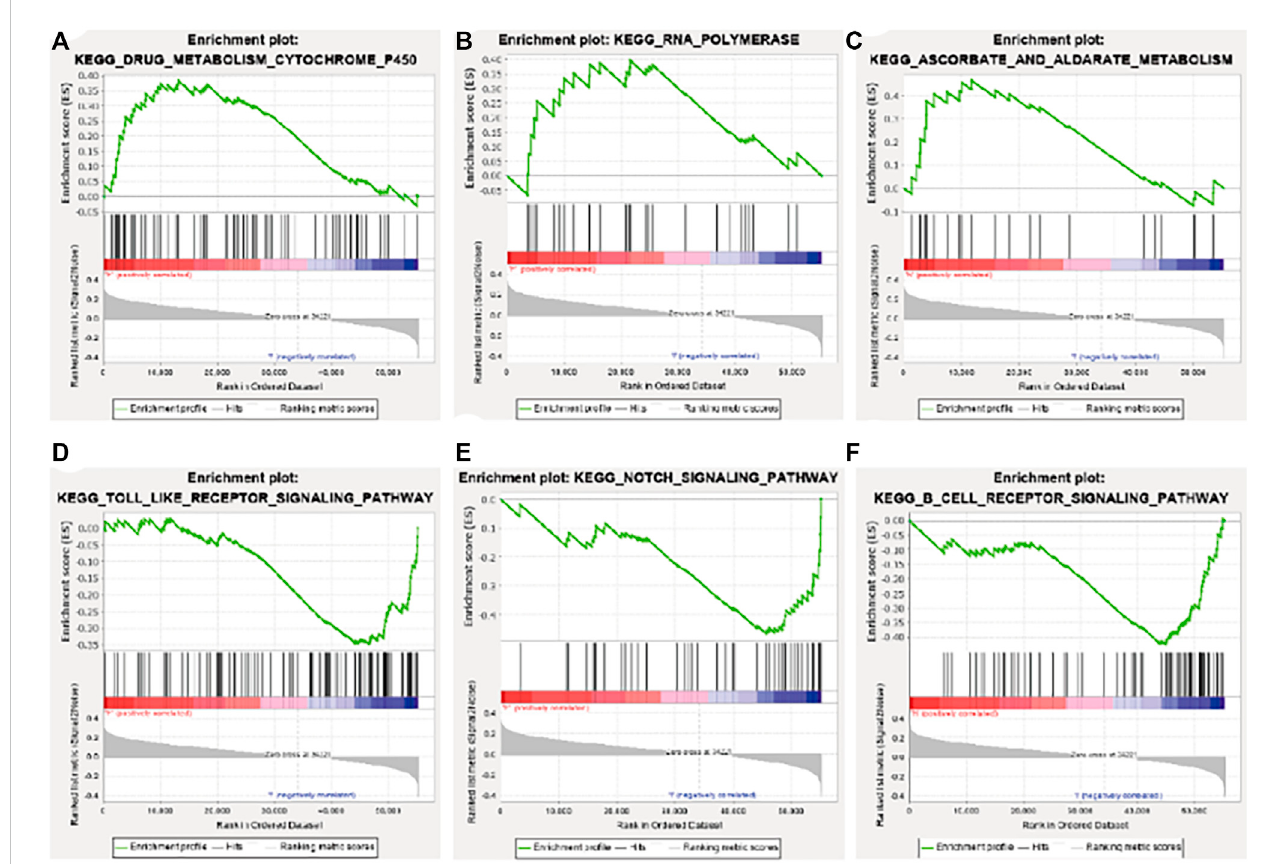
FIGURE 7 Gene set enrichment analysis enrichment results. (A) Drug metabolism cytochrome P450. (B) RNA polymerase. (C) Ascorbate and aldarate metabolism. (D) Toll-like receptor signaling pathway. (E) Notch signaling pathway. (F) B cell receptor signaling pathway. KEGG, Kyoto Encyclopedia of Genes and